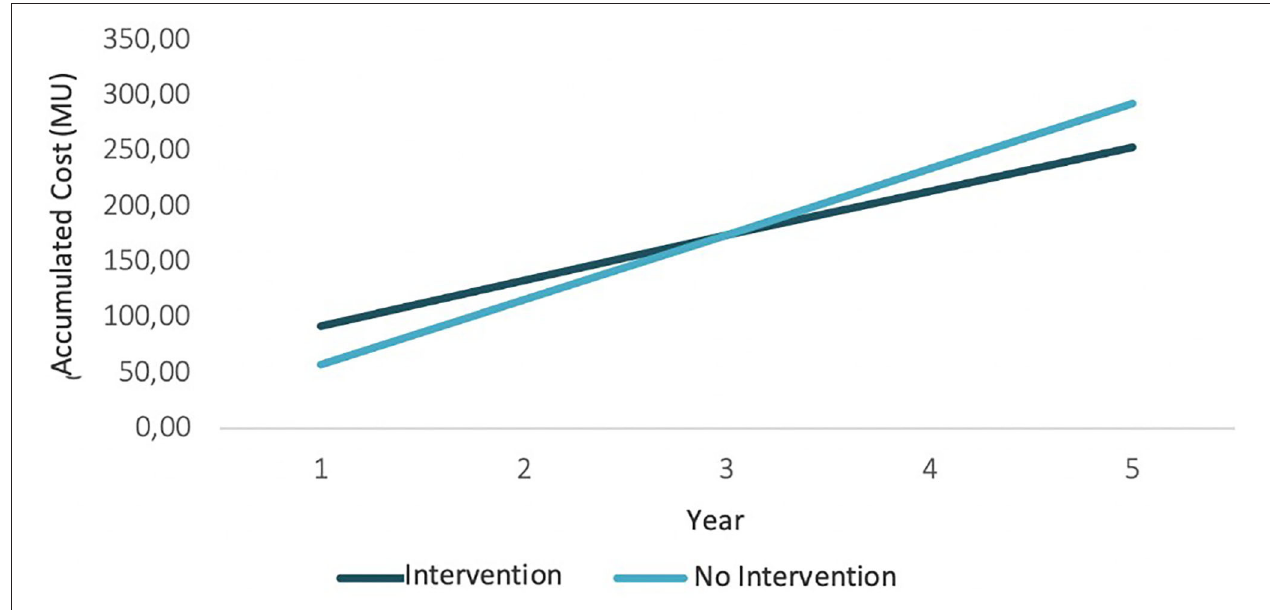
FIGURE 5 | Cost evolution